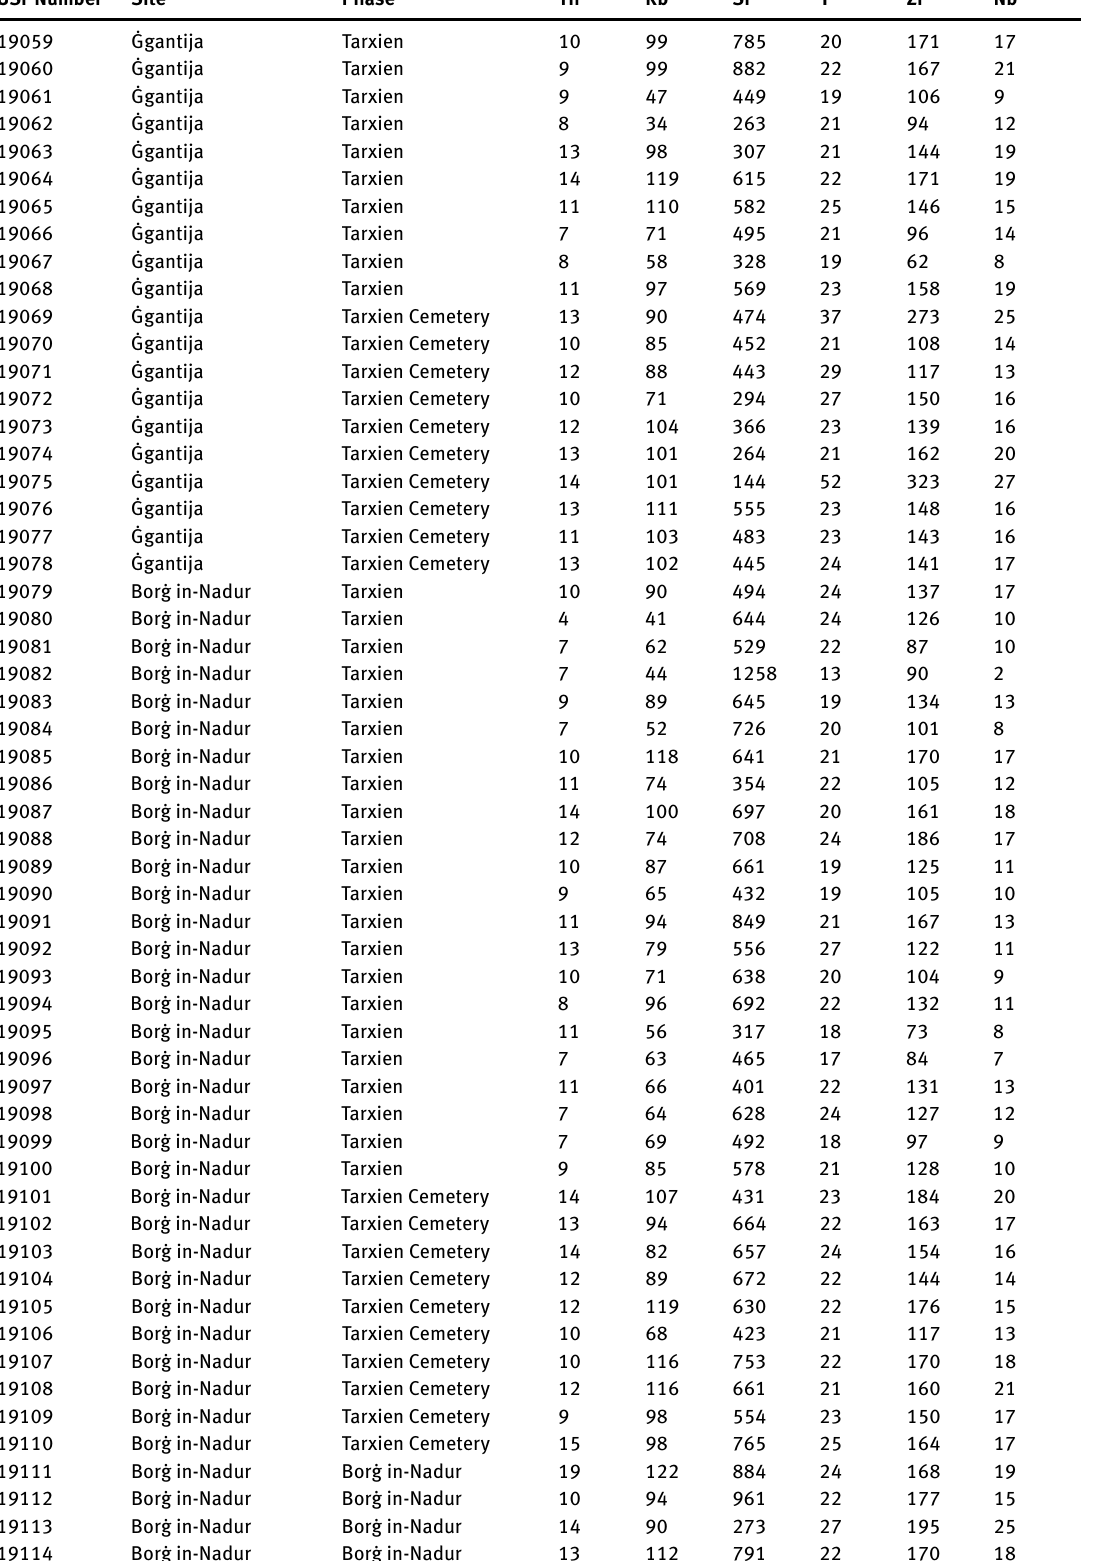
Table 2. Trace elemental data for ceramic materials (ppm). USF